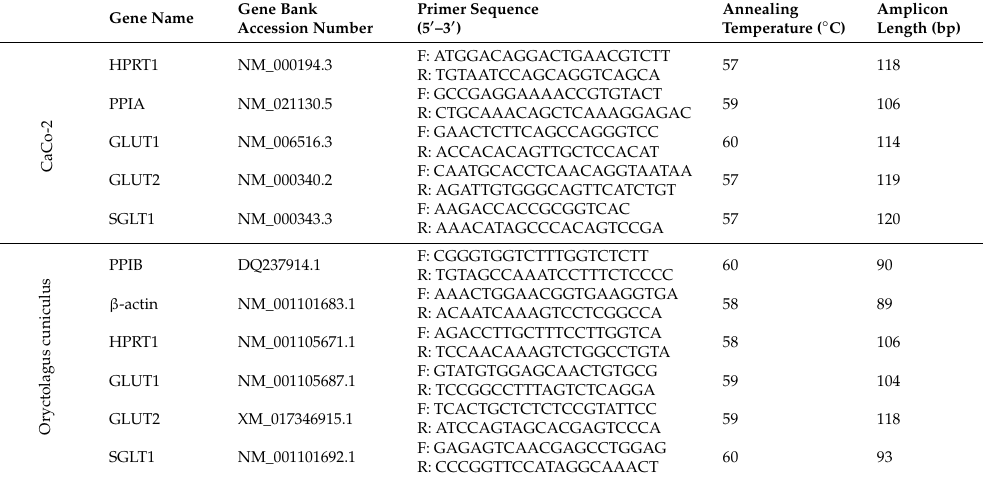
Table 2. Primers used for